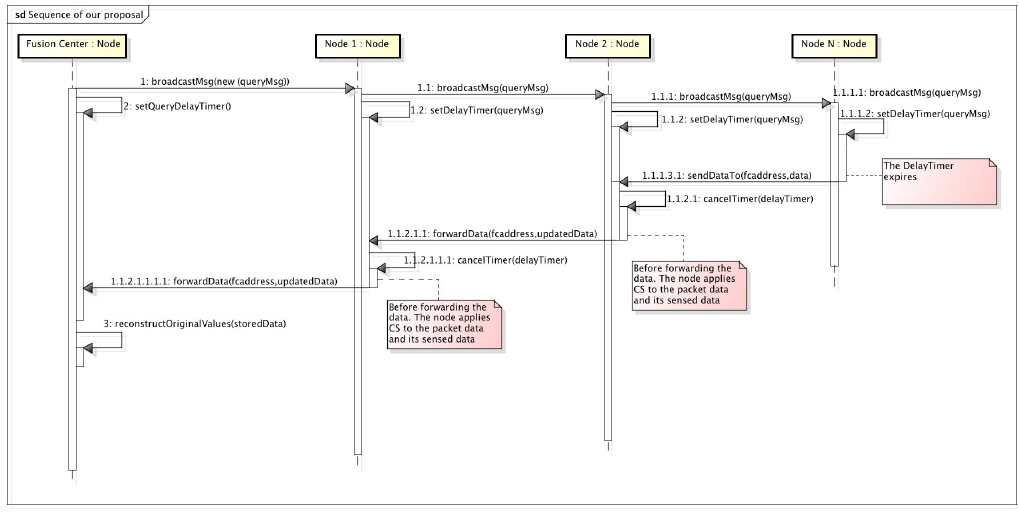
Figure 6. CS-Vehicular Data Harvesting (VDH) sequence diagram showing the query distribution and harvesting